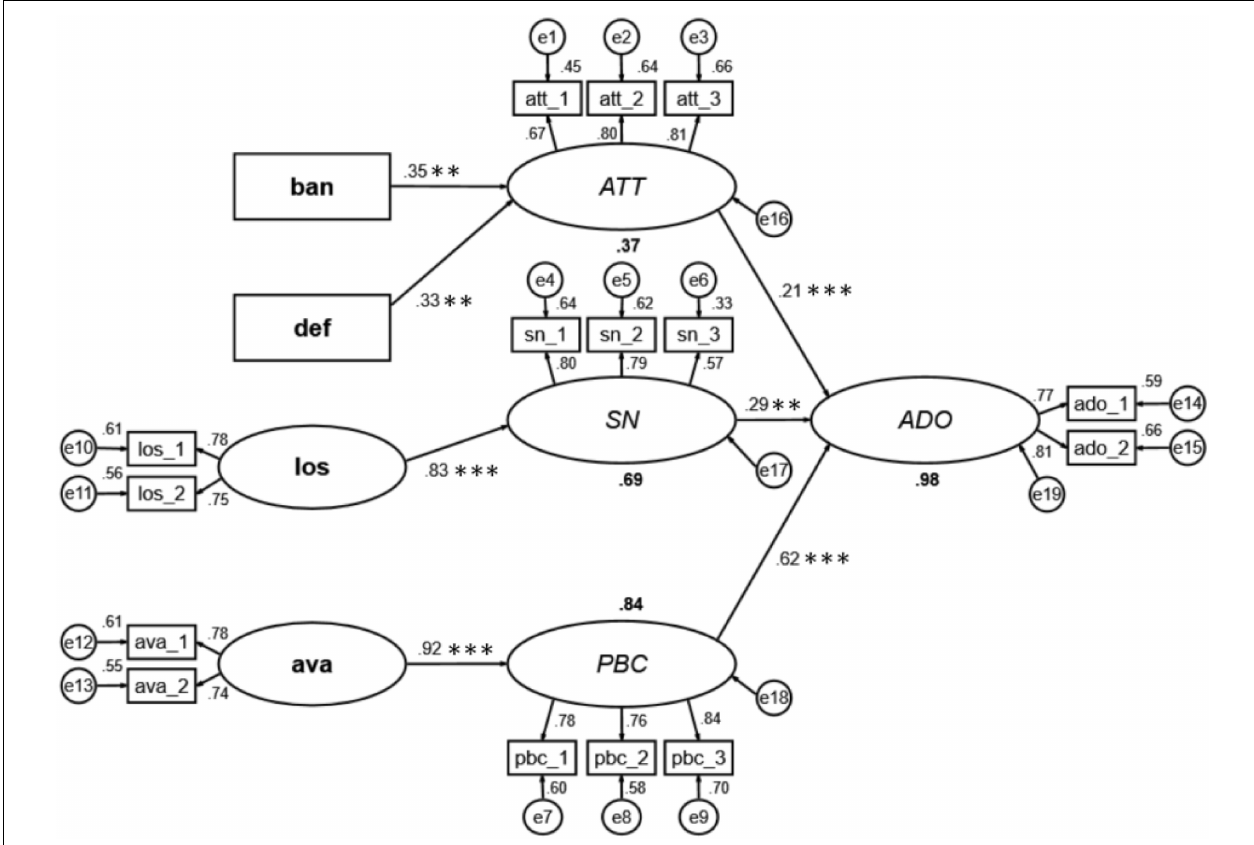
FIGURE 2 | The structural equation model. The determinants of the TPB are indicated in font italic; the biased beliefs are indicated in font bold. ATT, attitude; SN, subject norms; PBC, perceived behavior control; ADO, farmers’ adoption intention; ban, bandwagon bias belief; def, default bias belief; los, loss aversion bias belief; ava, availability bias belief. We have only shown the important paths. ∗∗ p < 0.01 and ∗∗∗ p < 0.001.